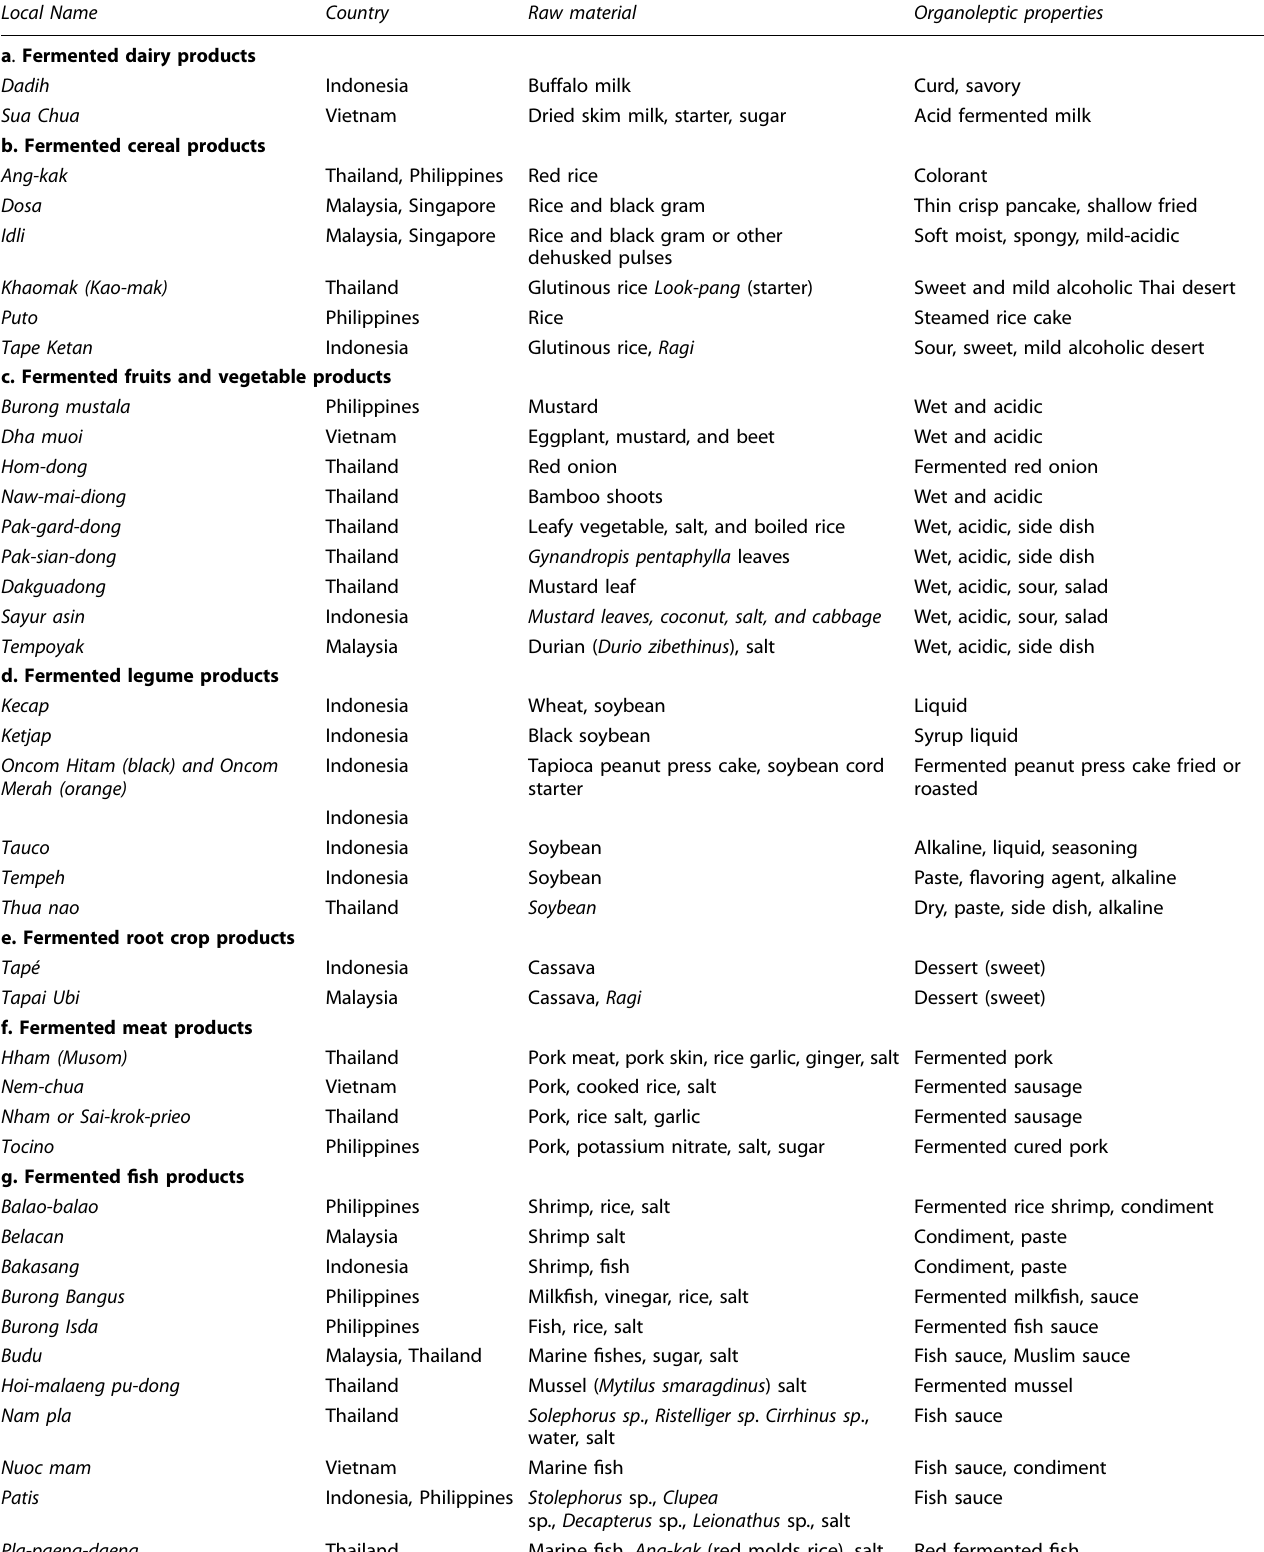
Table 1. a Indigenous dairy products in SEA, b indigenous fermented cereal products in SEA, c indigenous fermented fruits and vegetable sin SEA, d indigenous legume products in SEA, e indigenous fermented root crop products in SEA, f indigenous fermented meat products in SEA, g indigenous fermented fi sh products in SEA, h indigenous fermented alcoholic beverages in